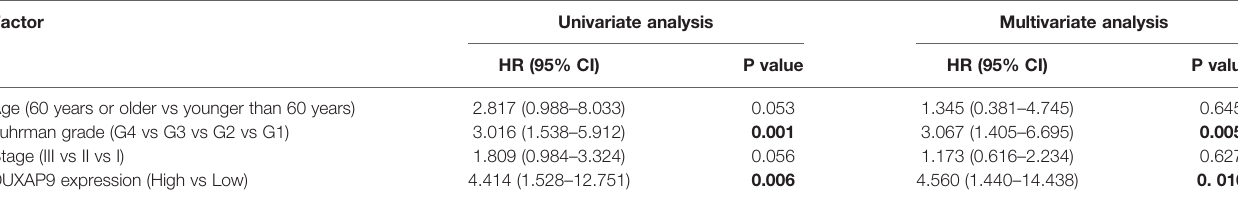
TABLE 1 | Univariate and multivariate analyses of factors predicting overall survival among localized ccRCC cases from SYSUCC Biobank. Factor